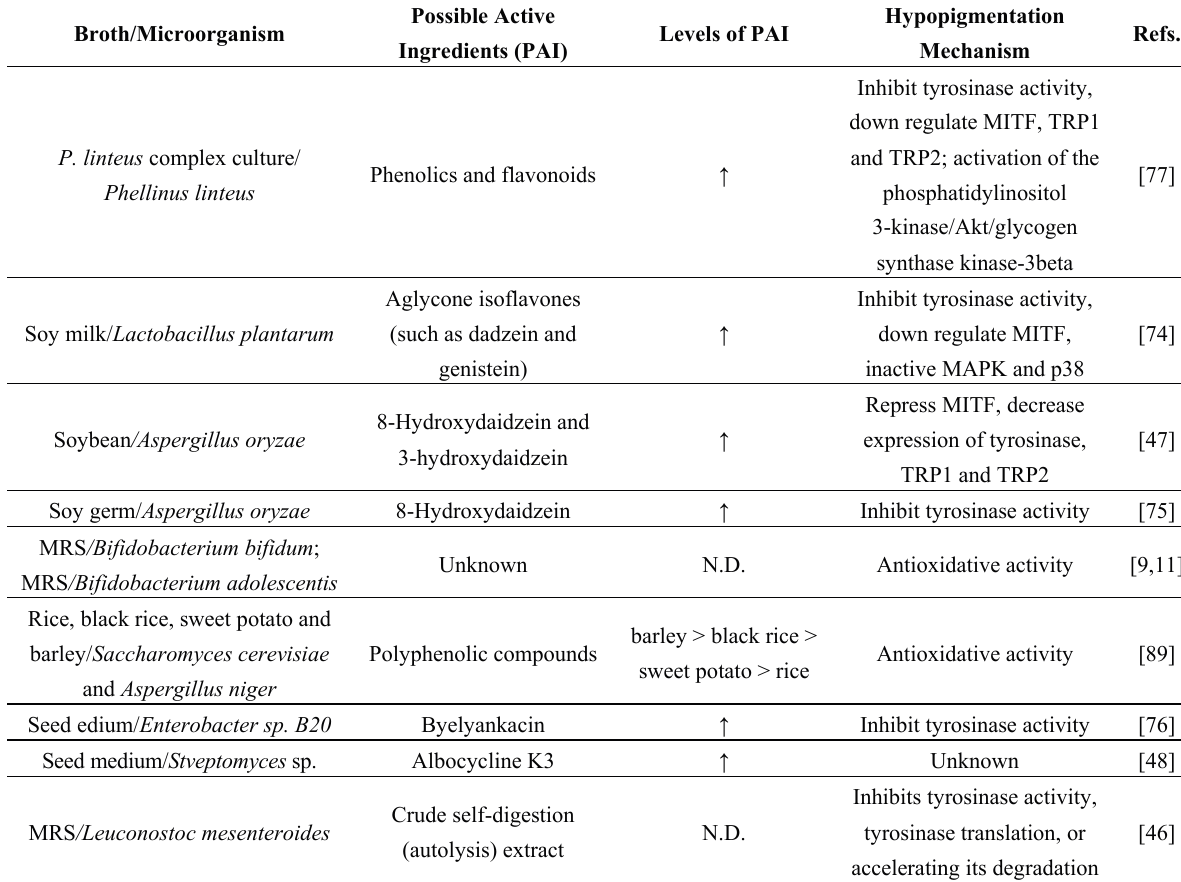
Table 2. Active ingredients and hypopigmentation mechanism of fermented